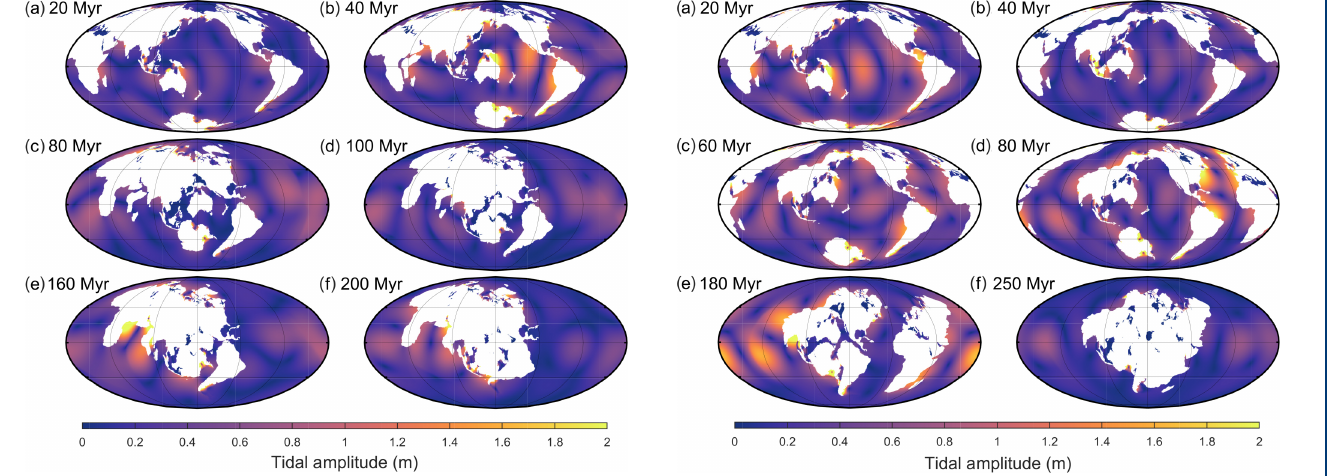
Figure 4. The same as in Fig. 2 but for the Novopangaea scenario. Figure 5. The same as in Fig. 2 but for the Aurica